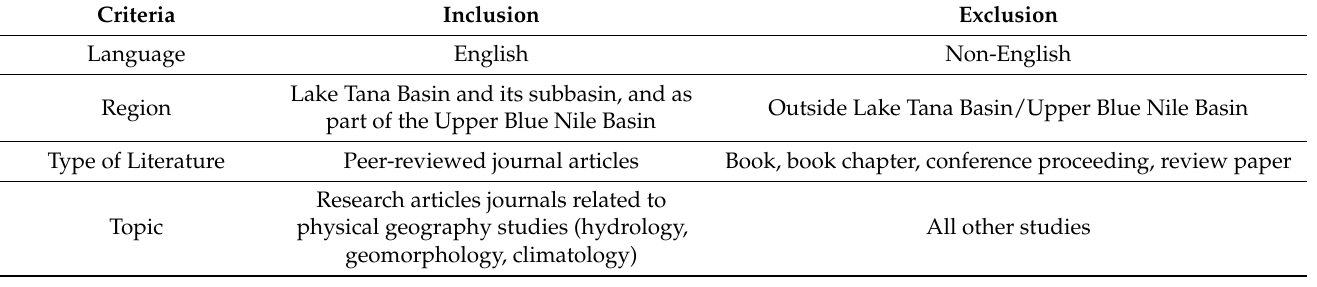
Table 1. The article selection criteria.